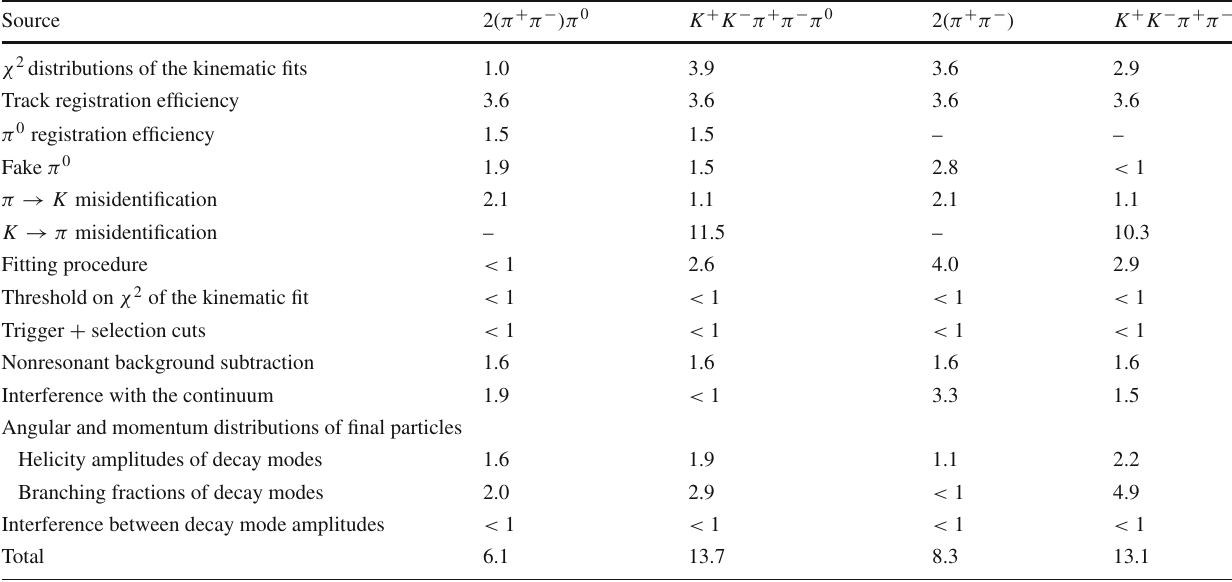
Table 2 Summary of systematic uncertainties (in %) for the measured branching fractions of the decays J /ψ → 2( π + π − )π 0 , J /ψ